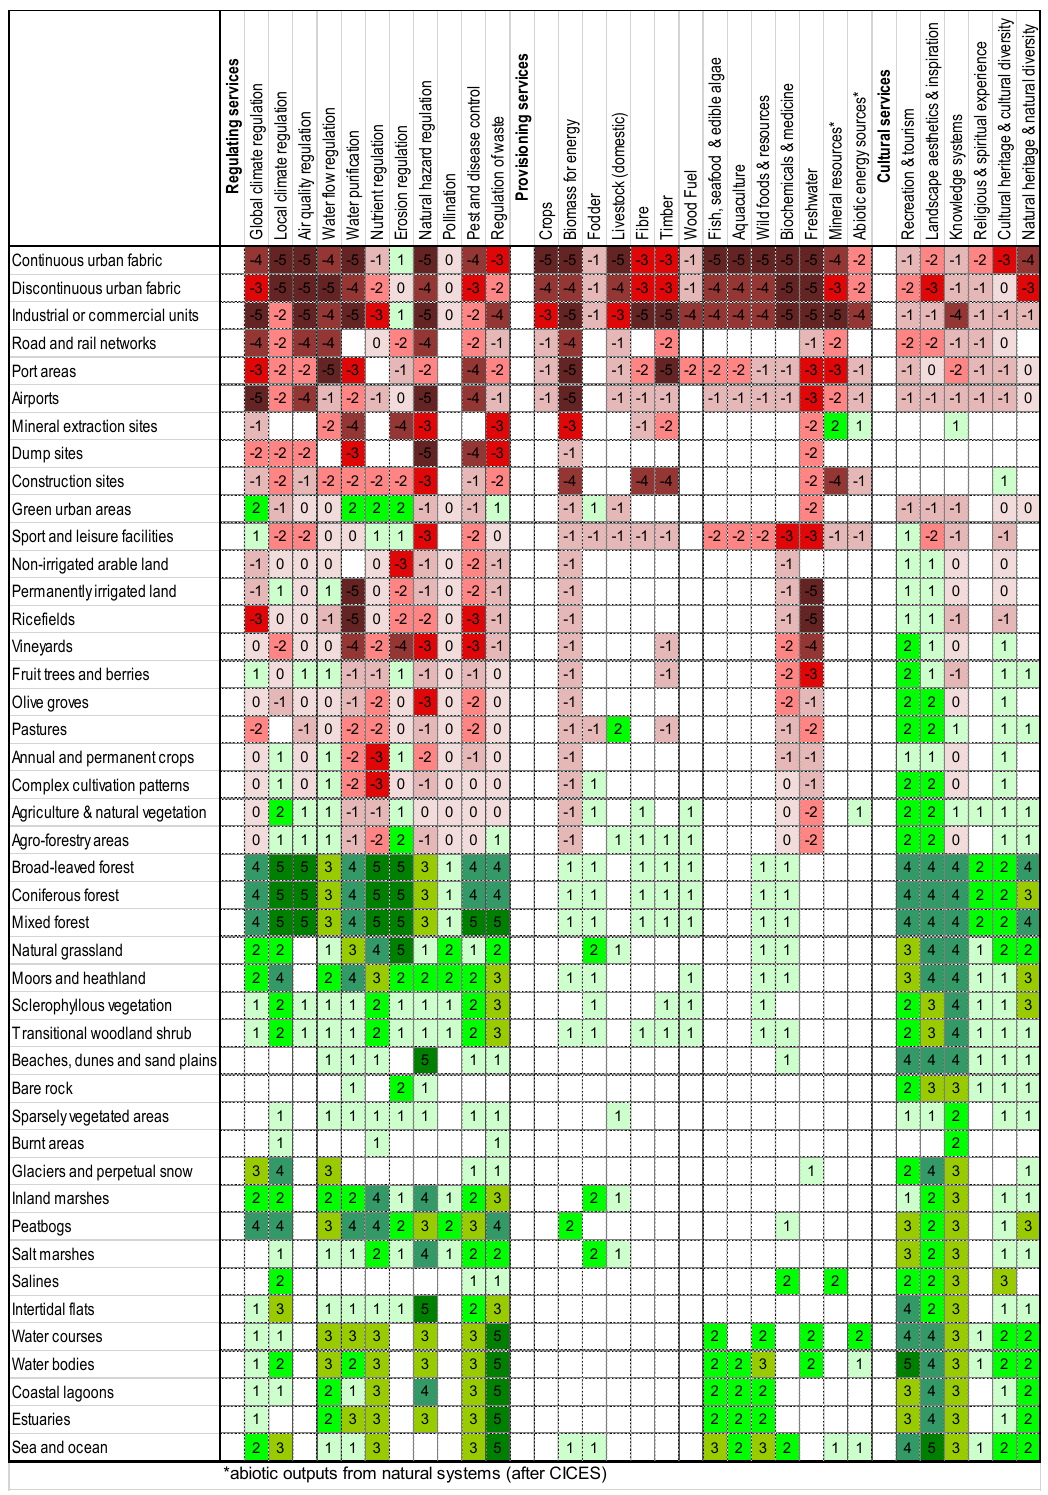
Figure 8: Exemplary ecosystem service flow - demand budget matrix. The exemplary evaluation refers to a hypothetical European „normal“ landscape in summer (before the harvest period). Scale from −5/brown red